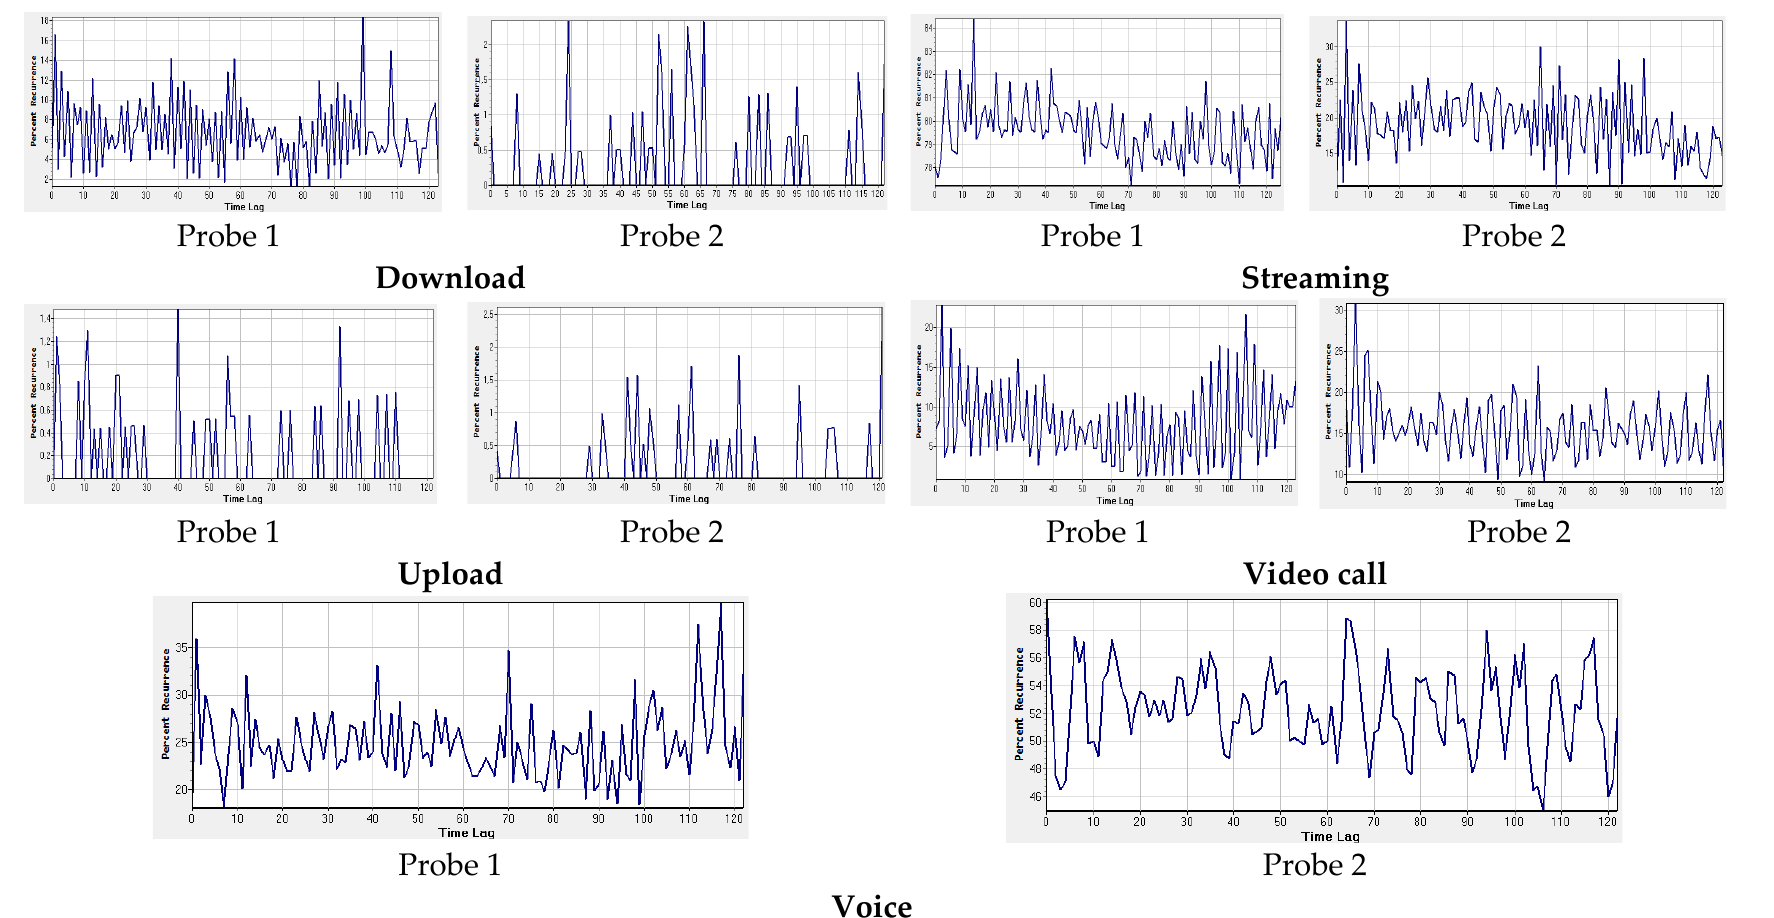
Figure 10. Recurrence histograms corresponding to all five mobile applications for Probe 1 and Probe 2 captures .